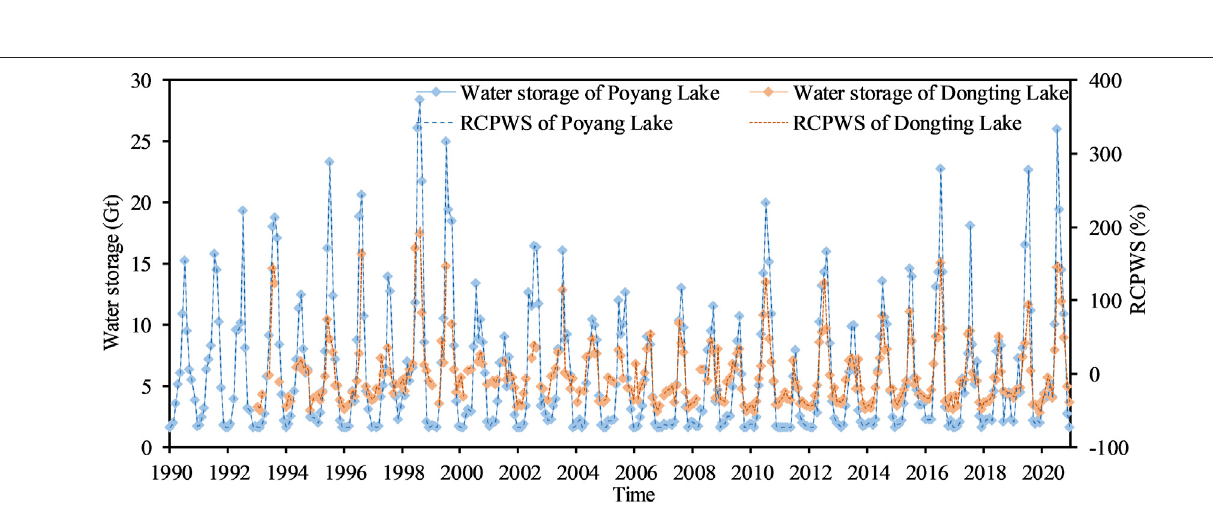
Frontiers in Environmental Science |